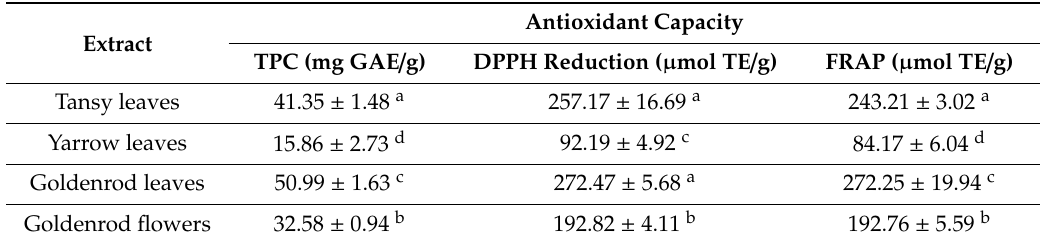
Table 2. Total phenolic content and antioxidant capacity of tested plant extracts.